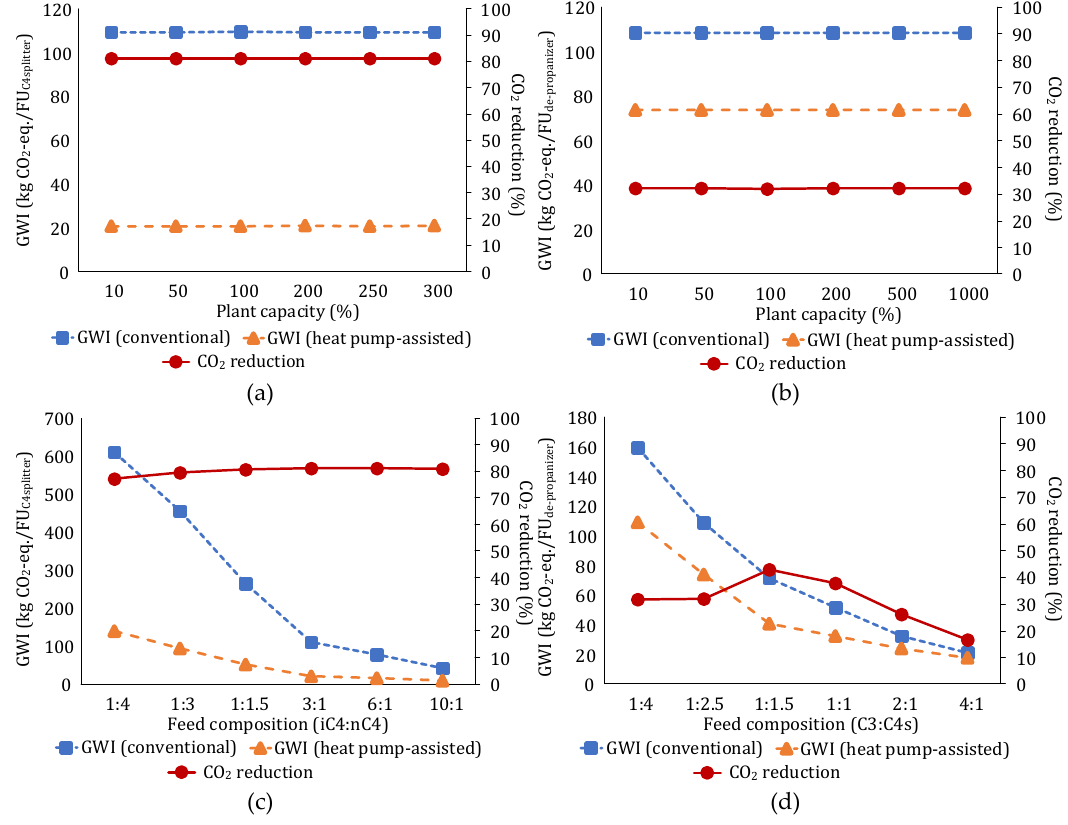
Figure 8. GWI (global warming impact) in kg CO 2 -equivalents (kg CO 2 -eq.) per functional unit (FU). ( a ) and (b) effect of the plant capacity on the GWI for the C4 splitter and the de-propanizer in conventional distillations, respectively and ( c ) and ( d ) effect of the feed composition on the GWI for the C4 splitter and the de-propanizer in heat pump-assisted distillations, respectively.